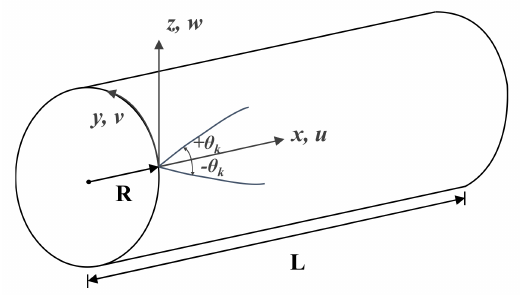
Figure 5. Notation of filament-wound